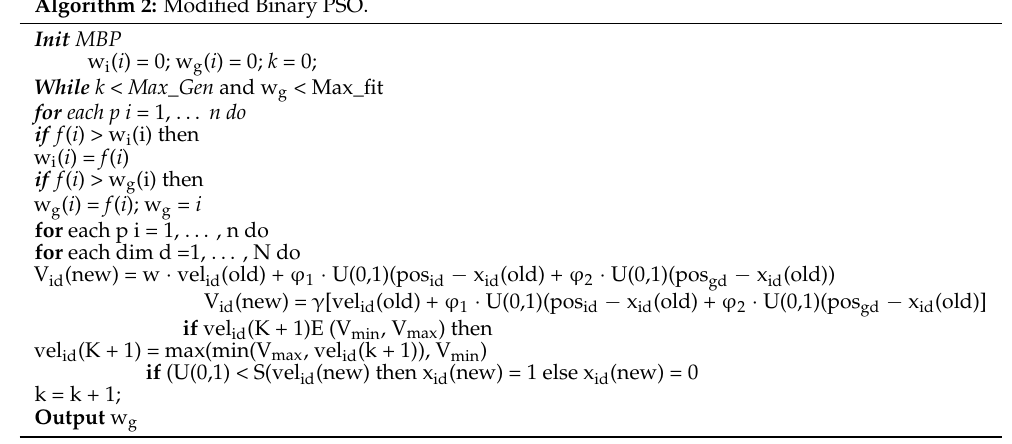
Algorithm 2: Modified Binary